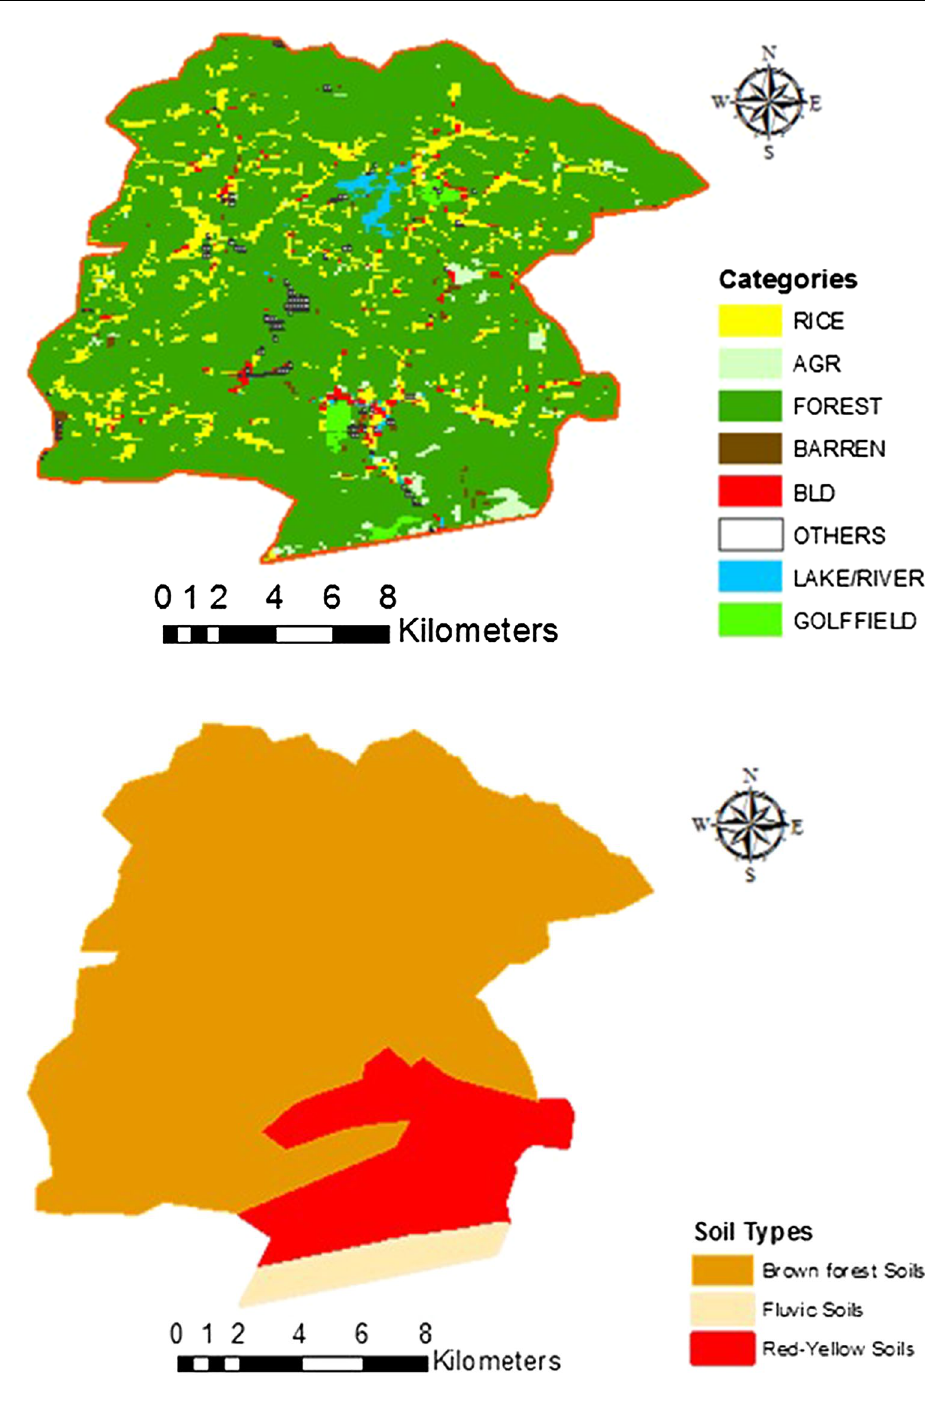
Fig. 3 Land-use map of upstream Kase River basin (1987)